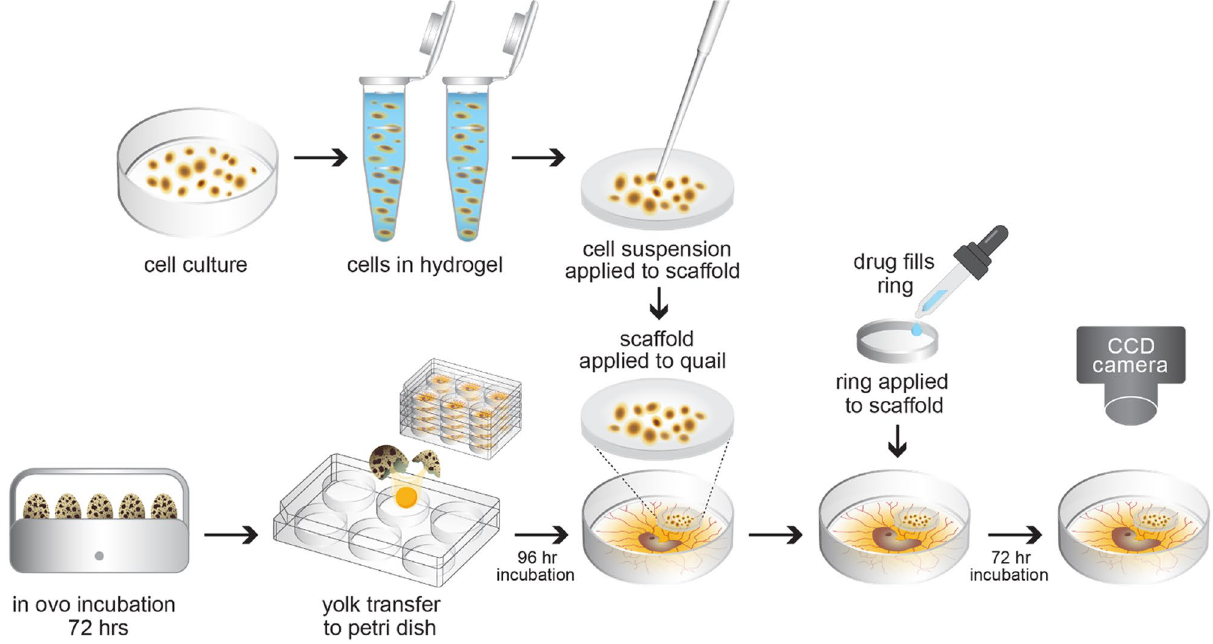
Figure 1. Schematic for the quail egg drug screening assay. The quail eggs are incubated for 72 h and then the embryos are transferred to six-well plates. The six-well plates are incubated for 96 h then any non-viable egg contents are removed. During the quail egg incubation, tumor cells are cultured. After the 96 h incubation the tumor cells are suspended in hydrogel, added to a 3D scaffold, and applied to the chorioallantoic membrane. A 9 mm ring is placed onto the 3D scaffold and then filled with P-10 osmotic beads soaked and equilibrated in the therapeutic compound. The quail is then incubated for 72 h. To analyze drug efficacy on tumor cells, luciferin is added to the scaffold and then imaged by a CCD camera to determine the total xenograft cell viability. Copyright holder Children’s Cancer Therapy Development